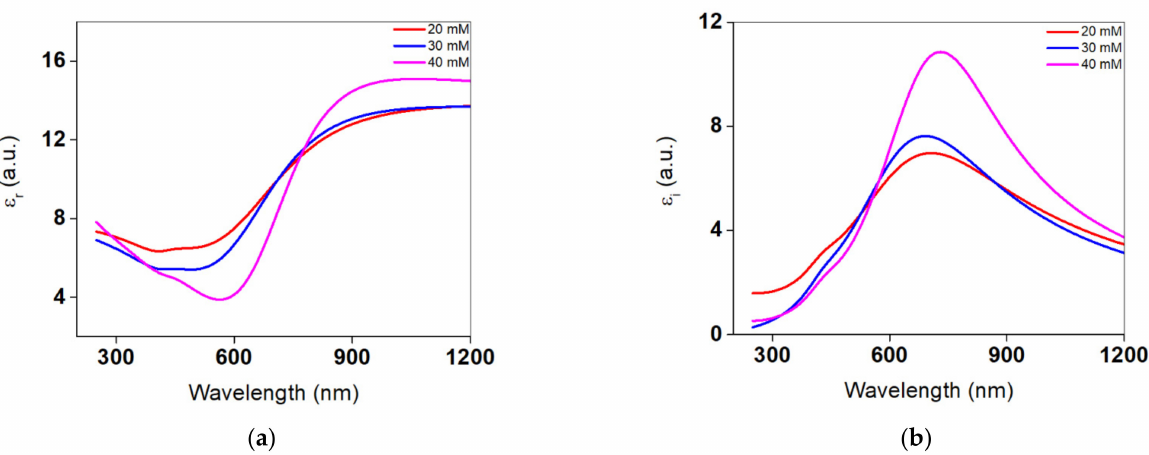
Figure A6. Dielectric functions (( a ) E r and ( b ) E i ) of Ag/PMMA samples at different